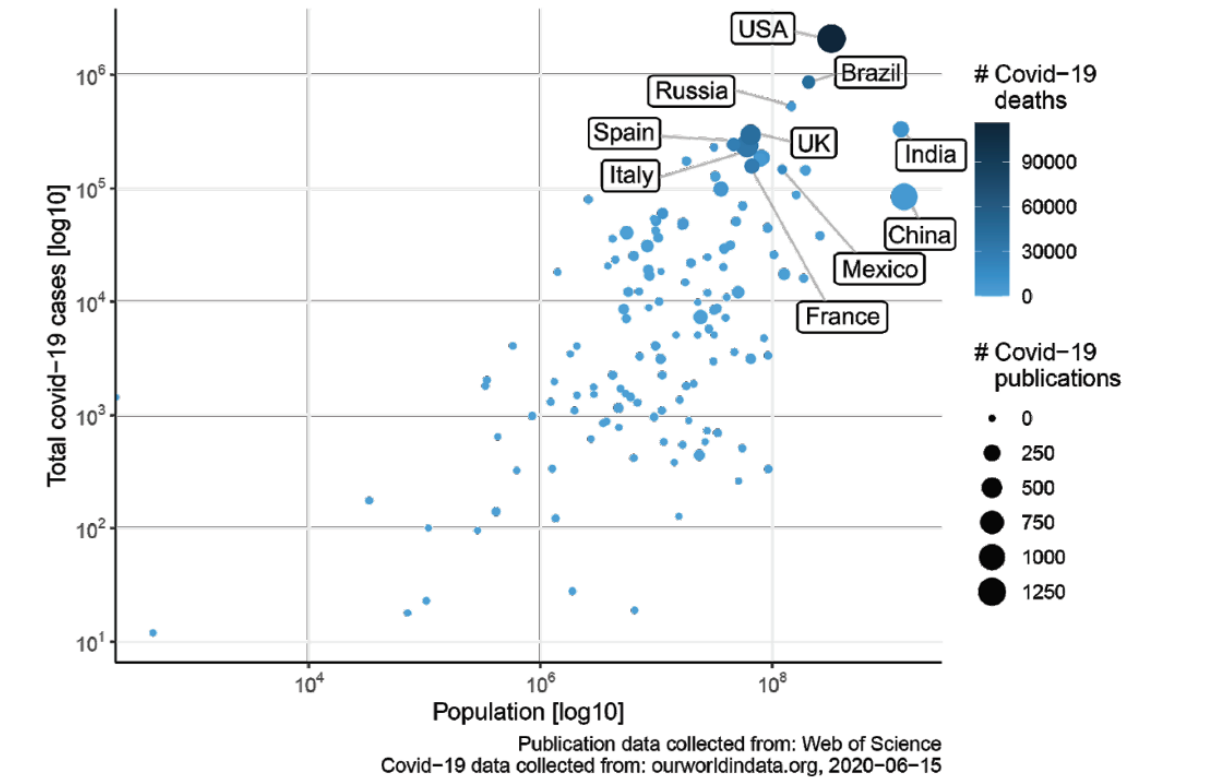
Figure 6. Population of countries versus the number of reported COVID-19 cases. Bubble sizes represent the number of publications; the color of the bubble represents the number of deaths. Data obtained from ourworldindata.org